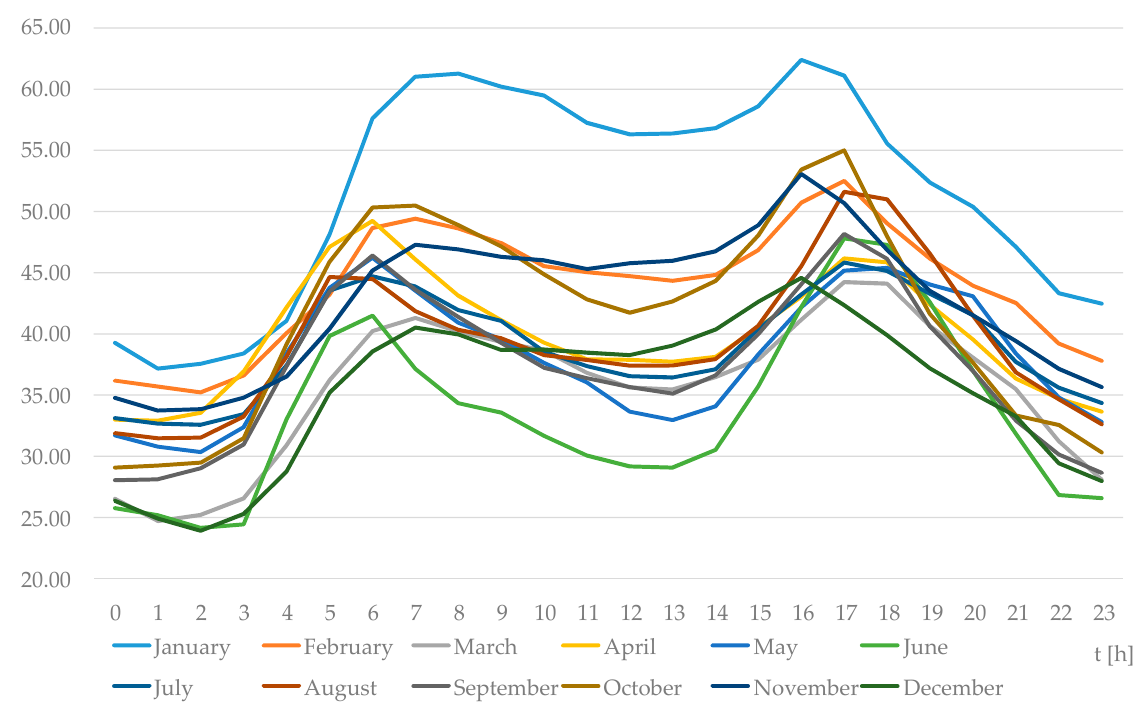
Figure 3. Average hourly price at the Danish DK2 electricity market for each month of 2019. Self-elaboration.